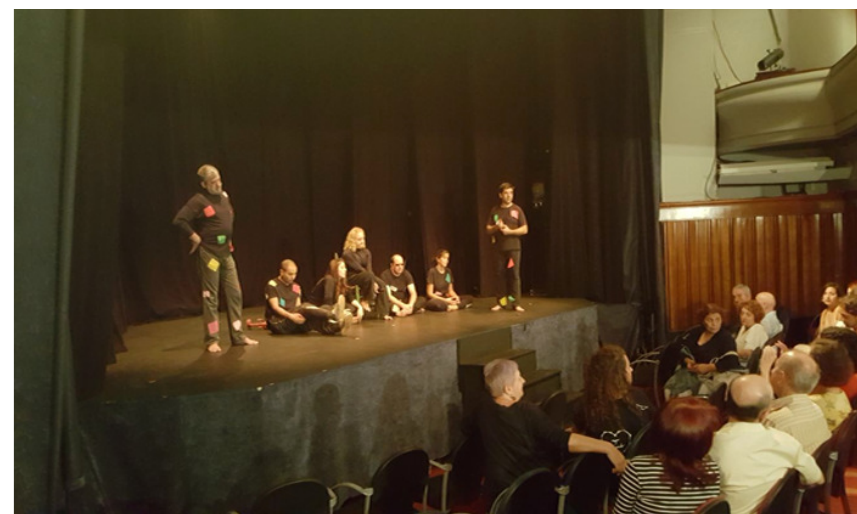
Figure 6. A debate between the actors and audience following a performance by Teatro de la